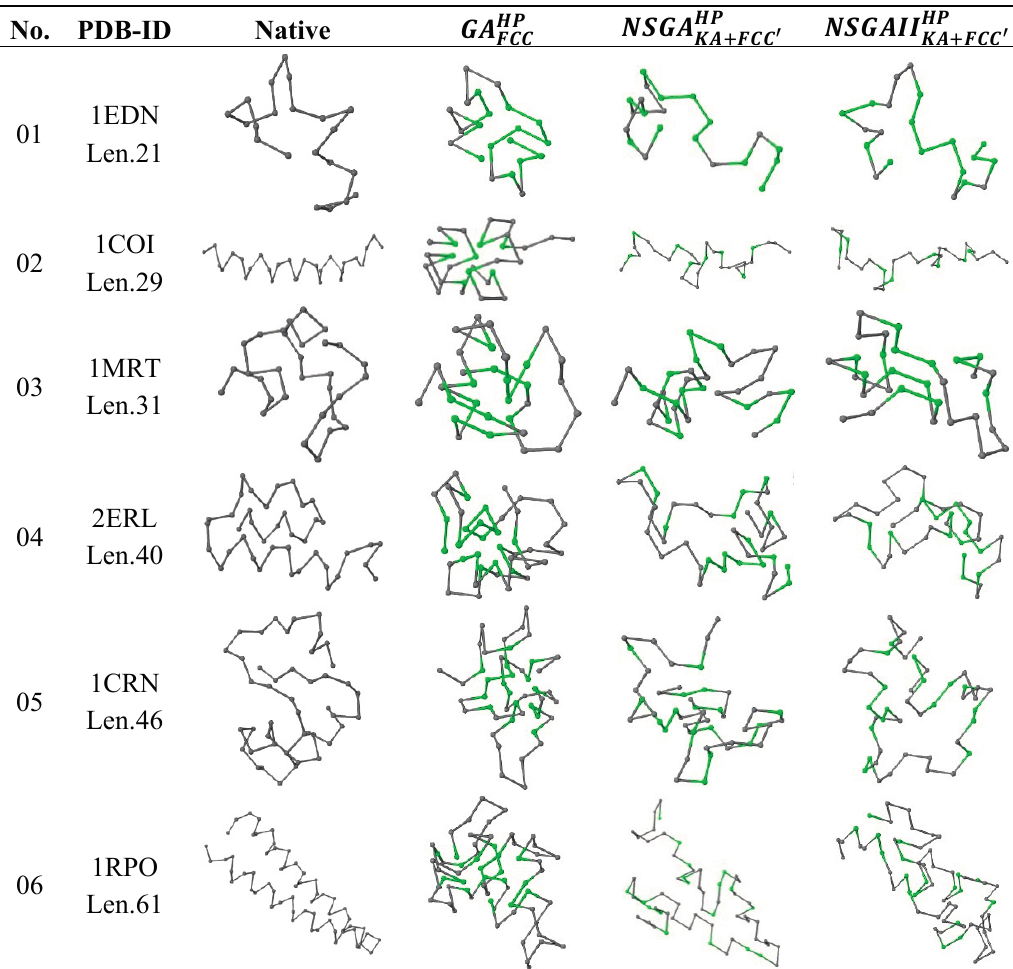
Table 1. Three different types of energy model for visual